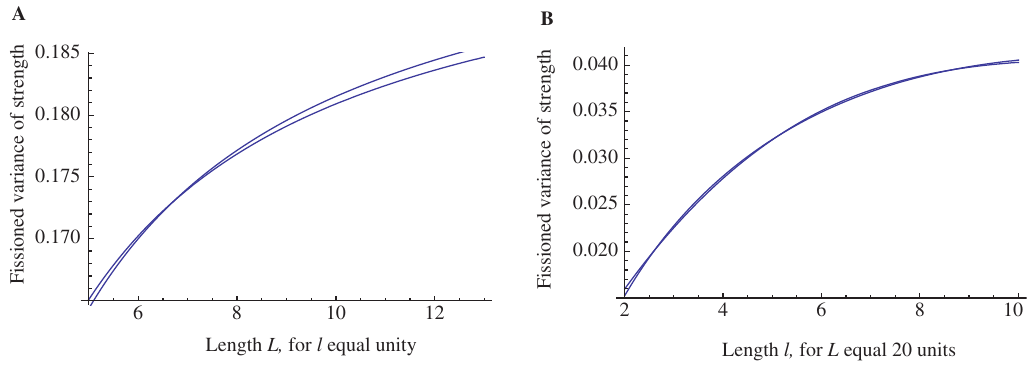
Figure 3 Similar to Figure 2, yet for the exponential autocorrelation function for strength.